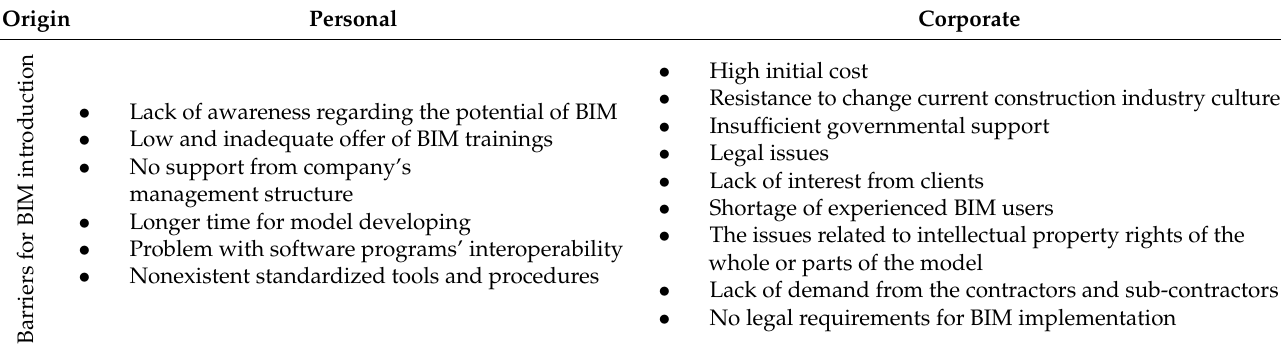
Table 2. Barriers for BIM